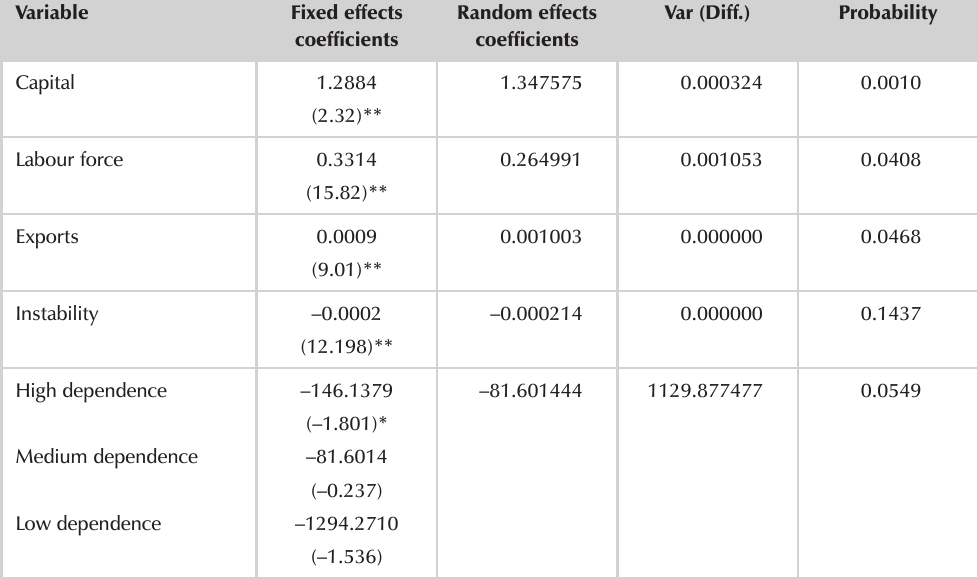
Comparison of panel data estimators: Dependent variable, output (GDP growth)